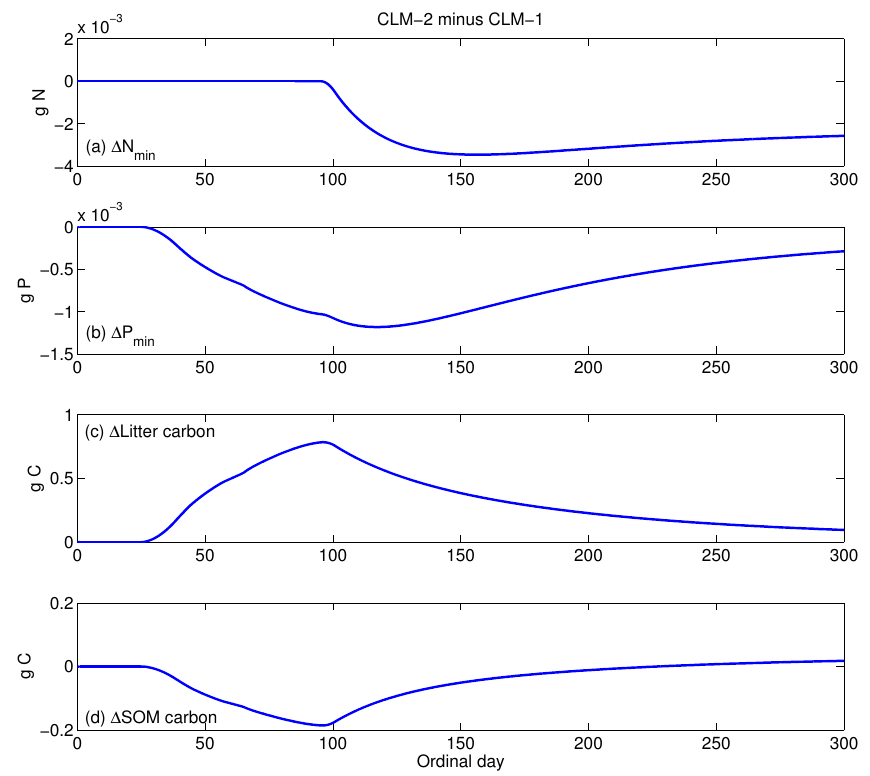
Figure 4. Differences between simulated decomposition dynamics by CLM-1 and CLM-2 for Case 3.